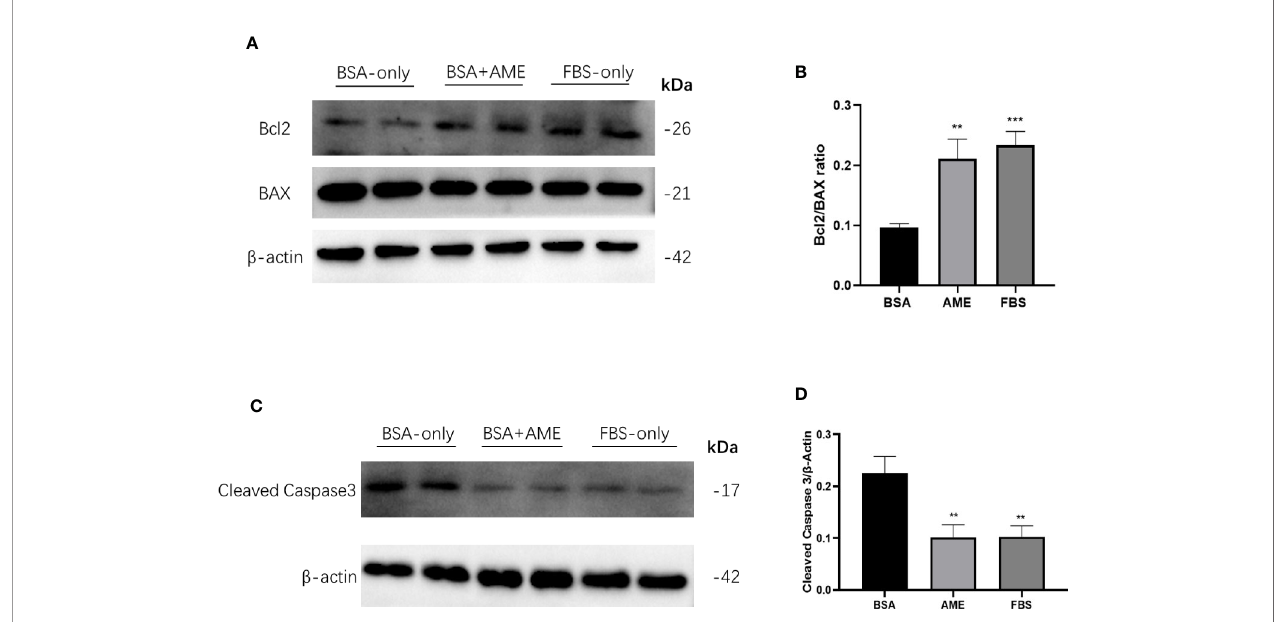
FIGURE 5 | AME increased Bcl2/BAX ratio and decreased the expression of cleaved caspase-3 (A) . and (C) Protein levels of Bcl2, Bax, cleaved caspase-3, and b -actin were assessed by Western Blot (B) . and (D) Quanti fi cation of protein levels showed the enhanced expression of Bcl2 after AME (0.5 mg/ml) treatment, while there was no signi fi cant change of the expression level of Bax (p > 0.05, One-way ANOVA). Further analysis of Bcl2/Bax ratio showed that AME signi fi cantly increased Bcl2/Bax ratio of serum-deprived islets (**p < 0.01 and ***p < 0.001 compared to BSA only group, one-way ANOVA). And the expression of cleaved caspase-3 was signi fi cantly decreased after AME treatment (**p < 0.01 vs. BSA only group, One-way ANOVA). Results are shown as means ± SD of three independent